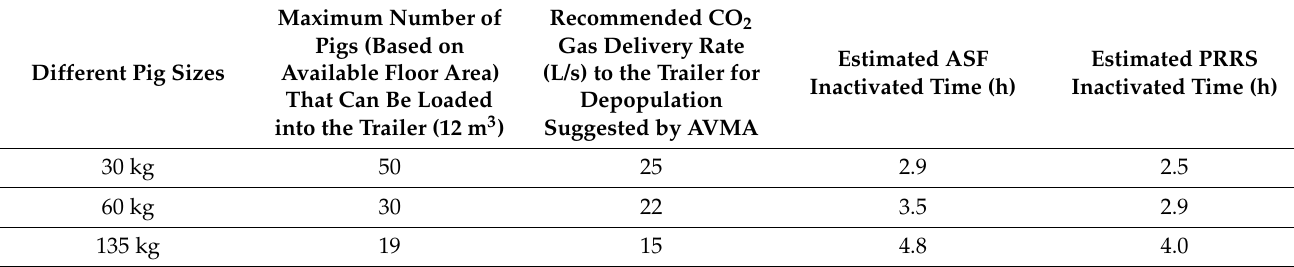
Table 6. Estimated ASF and PRRS inactivated time. Scaleup example for the all-in-one concept using the same trailer to depopulate and thermally treat 3 different pig sizes (30, 60, 135 kg). Outside set temperature: 0 ◦ C and carcass temperature: 38 ◦